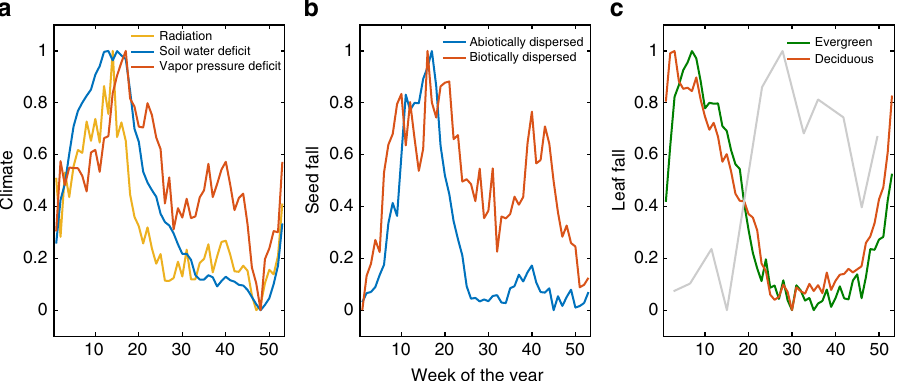
Fig. 2 Seasonality of climate and phenological variables. a Climate, b plant community-level seed fall, c leaf fall and leaf area index in the tropical forest on Barro Colorado Island, with plant species separated into groups based on their seed dispersal mode (66 abiotic and 174 abiotic in b ) and leaf habit (314 evergreen and 63 deciduous in c ). All variables are normalized to the range of 0 – 1 to facilitate visual comparison